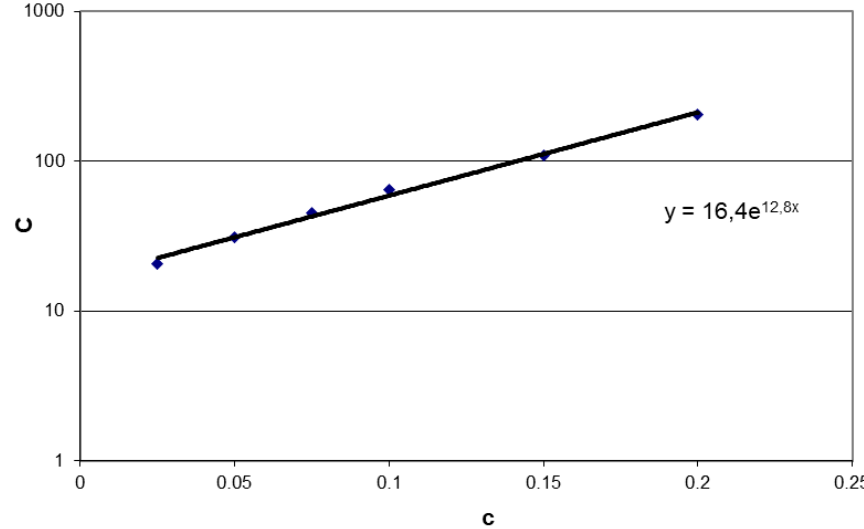
Figure 12. Plot of coe ffi cient C on c for folded, four-blade turbine.